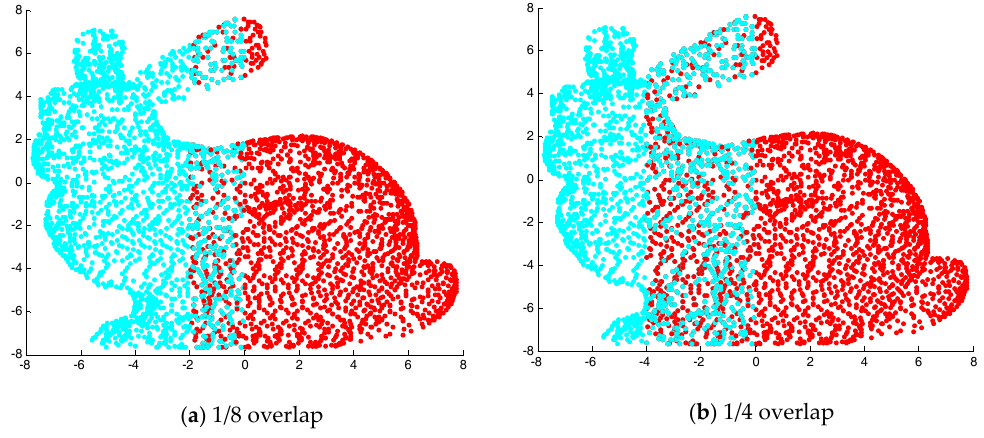
Figure 9. The overlap of point clouds.